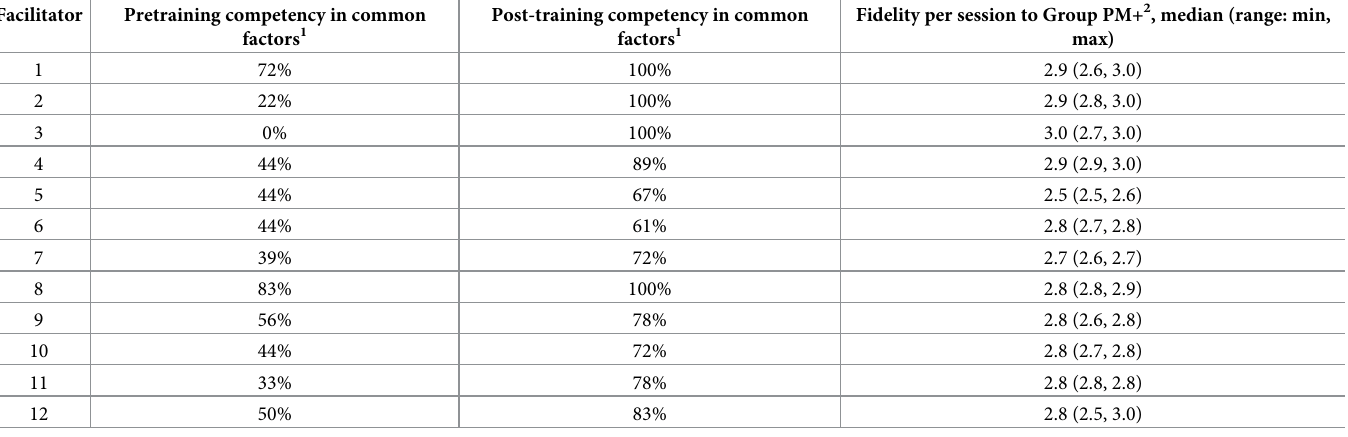
Table 2. Competency and fidelity of Group PM+